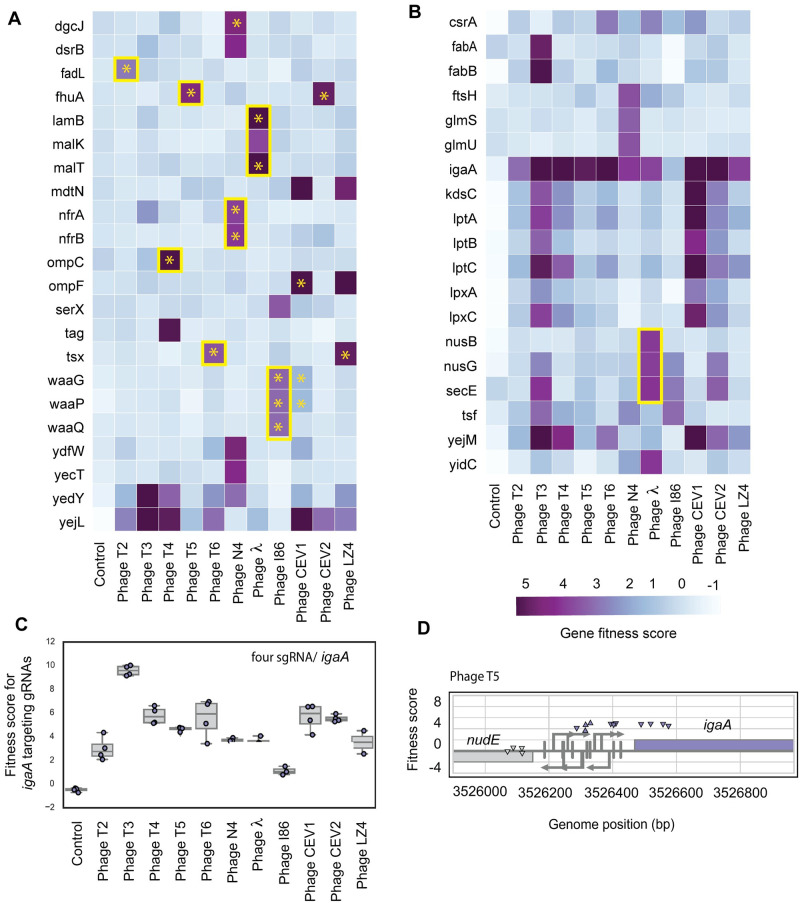
CRISPRi fitness profiles of E. coli nonessential and essential genes in the presence of diverse phages.(A) Heatmap of top-scoring nonessential genes across 11 phages. Yellow boxes highlight genes that encode phage receptors and are known to interfere with phage growth when down-regulated. Yellow stars indicate these data points are in agreement with RB-TnSeq results. (B) Heatmap of top-scoring essential genes across 11 phages. Yellow boxes highlight genes that are known to interfere with phage growth when down-regulated. (C) Box plot of fitness data for igaA-targeting sgRNAs across 11 different phages. Each data point in this plot is a specific sgRNA targeting igaA. (D) Genome browser plot for nudE-igaA locus with targeting sites for gRNAs and their fitness scores. The downward-facing triangles mean that the sgRNA targeted the nontemplate strand of the gene. Under each promoter, a vertical bar denotes the +1 for the promoter with the stem for the promoter starting at −60 relative to the transcription start site. The underlying data for this figure can be found in S1 Data. CRISPRi CRISPR interference; RB-TnSeq, random barcode transposon site sequencing; sgRNA, single-guide RNA.